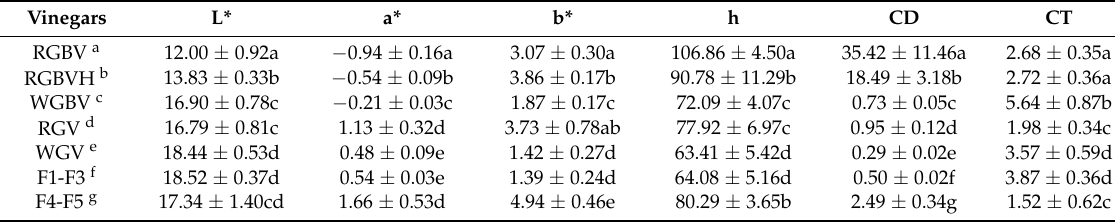
Table 4. Colour parameters of